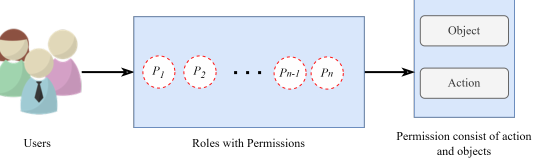
Figure 3. Naive representation of role-based access control system architecture.